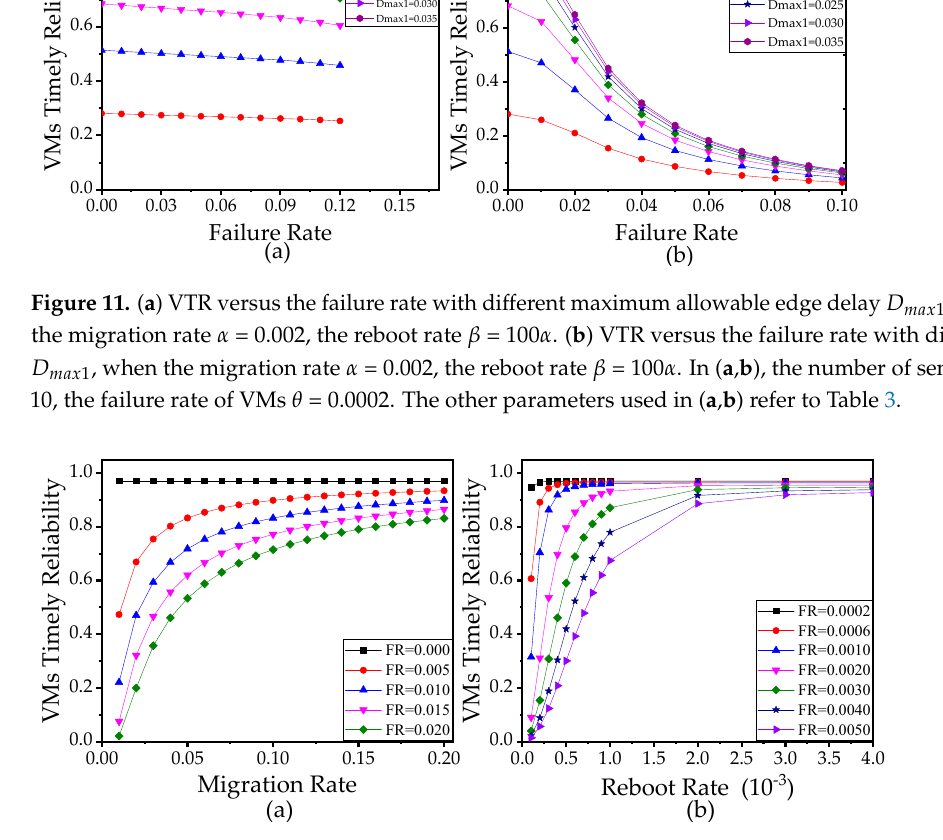
Figure 12. ( a ) VTR versus the migration rate with different failure rates (FR). ( b ) VTR versus the reboot rate with different failure rates (FR). In ( a ) and ( b ), the number of sensors is 10. The other parameters used in ( a ) and ( b ) refer to Table 3.